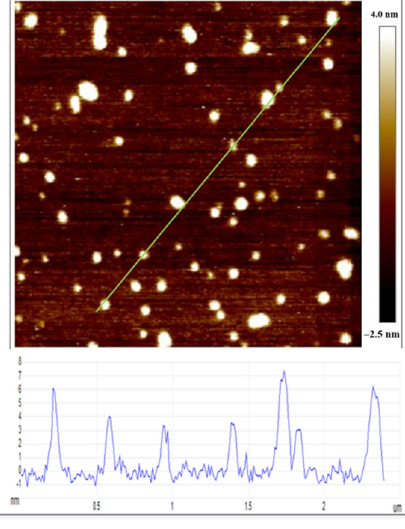
Figure 2. AFM image of GQDs.